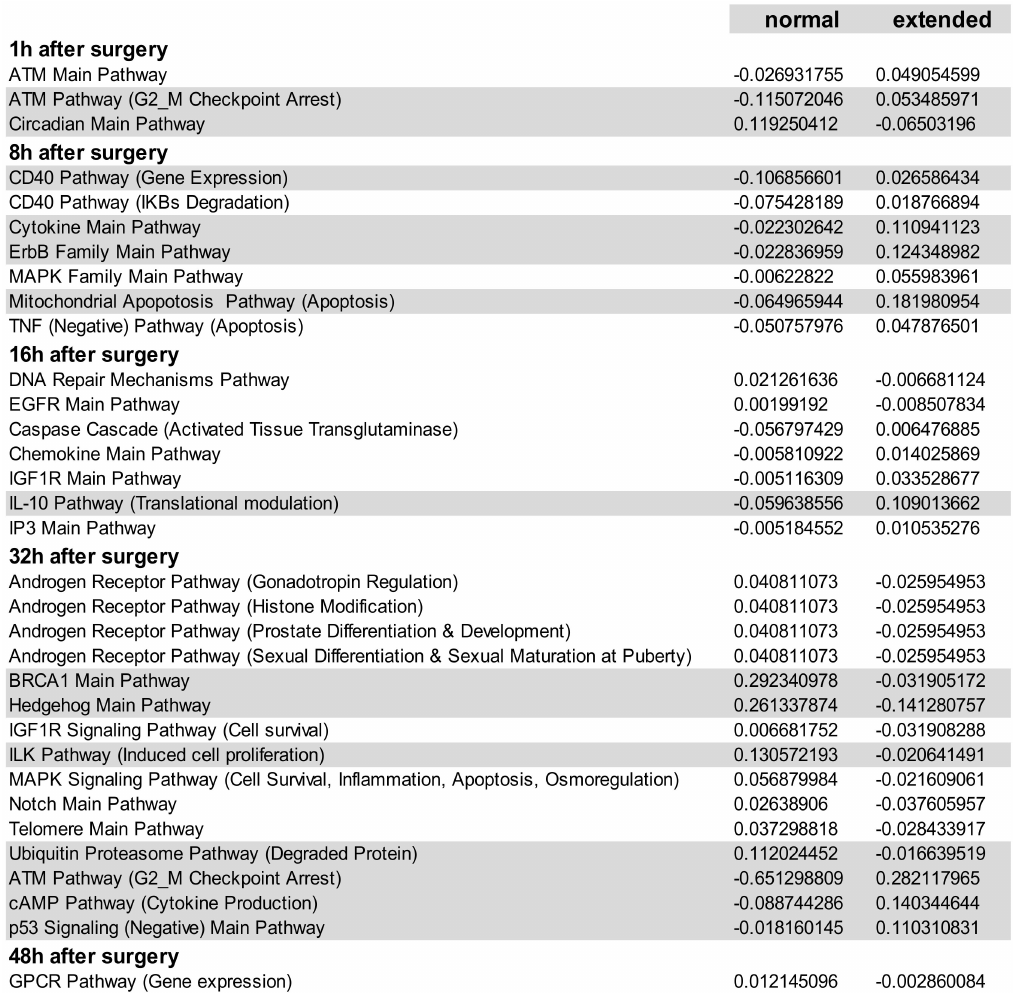
Table 3. Physical properties of the test